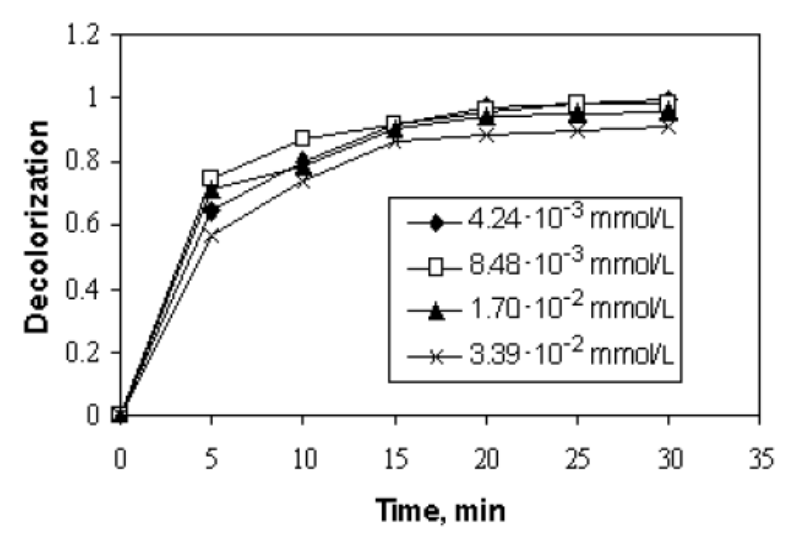
Fig. 9 Effect of Co 2+ ions on AOP in alkaline medium. Initial conditions: C dye =50 mg/L, [H 2 O 2 ]= 17.318 mM.